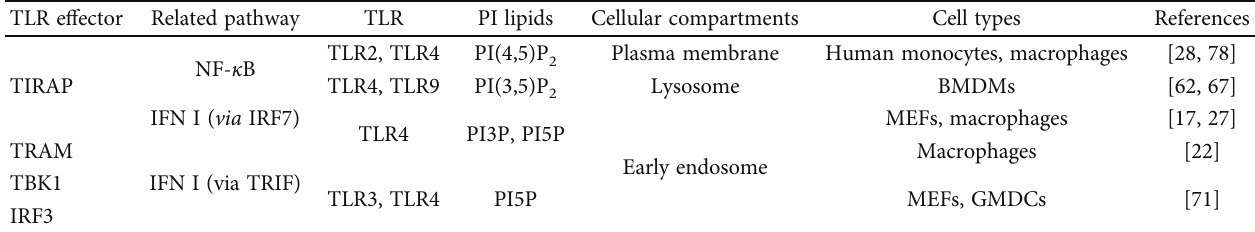
Table 1: Cellular compartments for TLR signaling e ff ector recruitment.